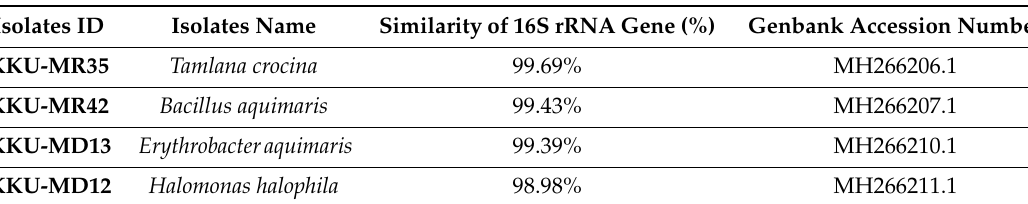
Table 1. Summary of molecular identification of potential poly-β-hydroxybutyrate-producing marine bacteria.